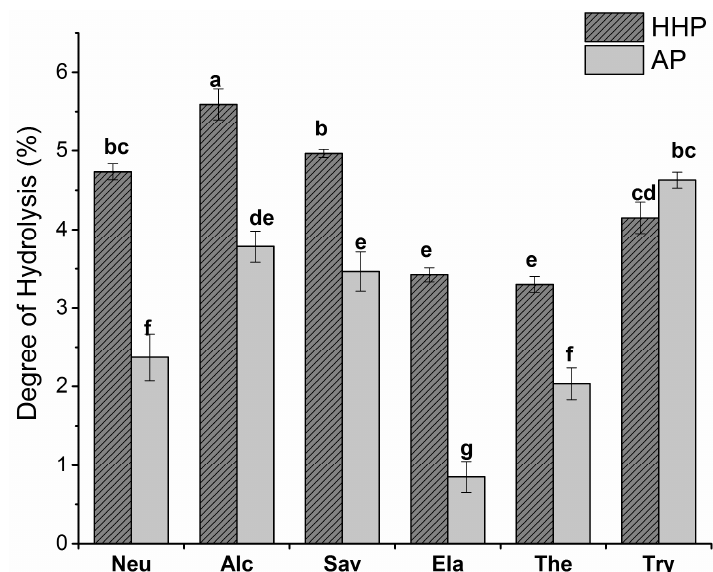
Figure 1. The degree of hydrolysis of β -lactoglobulin (BLG) hydrolyzed under atmospheric (AP) and high hydrostatic pressure (HHP) at an enzyme-to-substrate (E:S) ratio of 1:100. The statistical analysis of the results was performed by two-way ANOVA followed by a Duncan multiple comparisons test. The bars and error bars represent means and standard errors, respectively ( n ≥ 3). Means with different lowercase letters differ significantly ( p < 0.05).